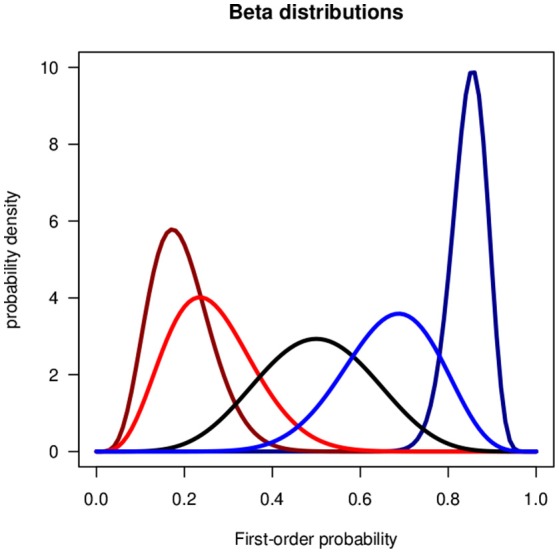
Beta distributions for the verbal phrases of the Lichtenstein and Newman data in Table 1. From (left) to (right): Very unlikely, unlikely, about as likely as not, likely, very likely.